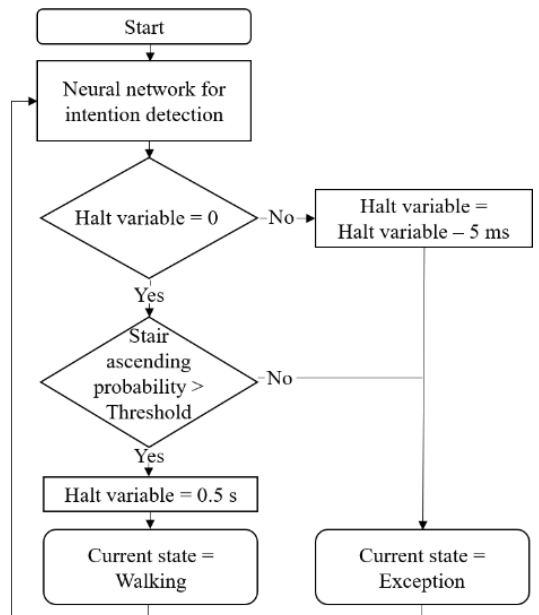
Figure 6. Algorithm for the state decision. If the probability of the stair ascending state output by the NN exceeds the threshold, change the current state to stair ascending. After that, the current state becomes the exception state for 0.5 s, so that one stair ascending action is not detected as multiple stair ascending actions.